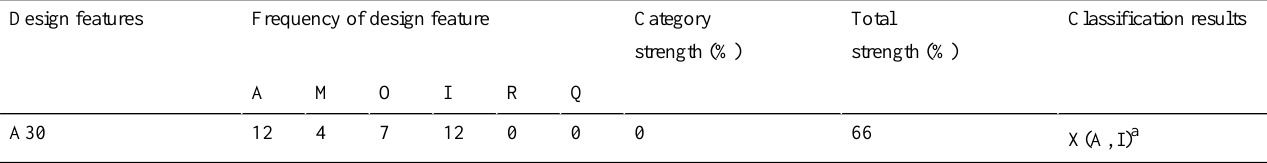
Table 10. Categorizing design features by low self-efficacy participants